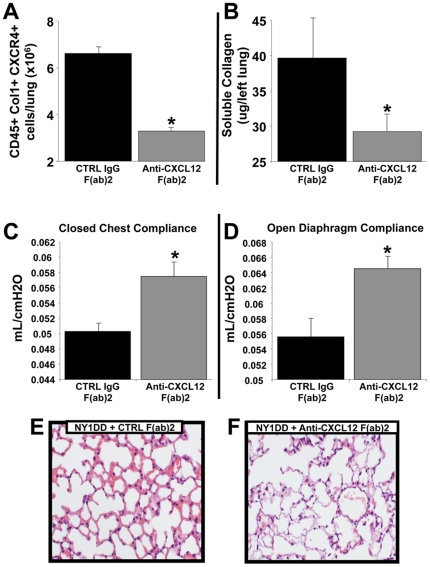
Depletion of CXCL12 under baseline conditions in NY1DD SCD mice reduces the number of fibrocytes within their lungs, and this is correlated with a reduction in collagen deposition and improvement in lung compliance and histopathology.A) demonstrates that passive immunization of NY1DD mice with anti-CXCL12, as compared to appropriate control F(ab)2 antibodies markedly attenuates the presence of fibrocytes in the lungs of NY1DD mice under baseline conditions. B) demonstrates that passive immunization of NY1DD mice with anti-CXCL12, as compared to appropriate control F(ab)2 antibodies reduces the amount of soluble collagen in the lungs of NY1DD mice under baseline conditions. C–D) demonstrates that passive immunization of NY1DD mice with anti-CXCL12, as compared to appropriate control F(ab)2 antibodies improves the compliance of the lungs of NY1DD mice under baseline conditions. E–F) demonstrates that passive immunization of NY1DD mice with anti-CXCL12 (F), as compared to appropriate control F(ab)2 antibodies (E) improves the histopathology of the lungs as demonstrated by the H&E photomicrographs. N = six mice in each group for A–D, lung photomicrographs (E–F) are representative of six lungs from each group. * p = <0.05.